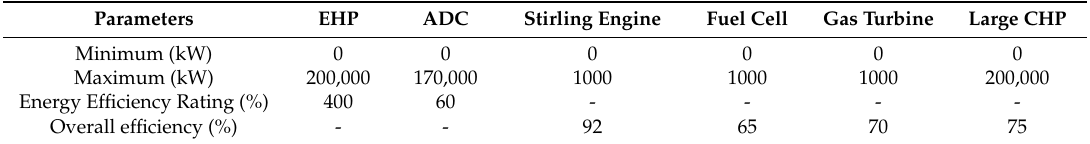
Table 1. Energy generation limits and energy efficiency ratings.